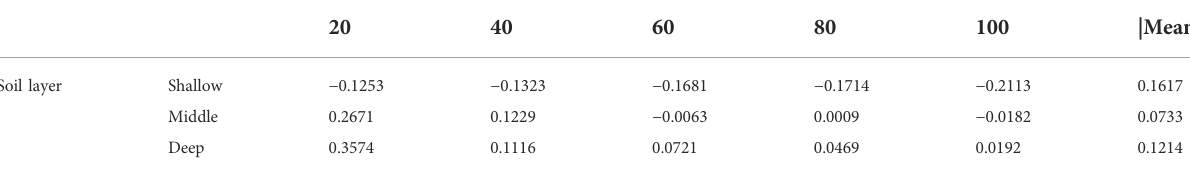
TABLE 4 Final stable lateral stresses